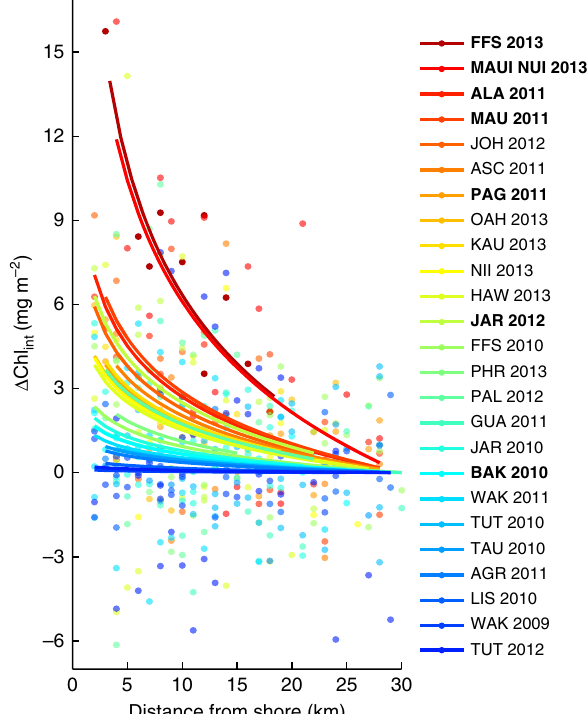
Figure 4 | Phytoplankton enhancements below the surface. Relationship between changes in depth-integrated chlorophyll- a ( D Chl int ) and distance from shore for 25 in situ surveys across 21 Pacific coral reef islands and atolls. Nonlinear regression fits are colour-coded based on the rate of increase in D Chl int ; red (blue) fits have a stronger (weaker) rate of increase in D Chl int towards shore across all surveys. Location and survey year are shown (right). Bold indicates significant relationships ( P o 0.05). All information is centred to have a value of zero Chl int at 30km, the spatial extent of satellite observations presented herein. Please see Fig. 2 for island and atoll geographic locations.